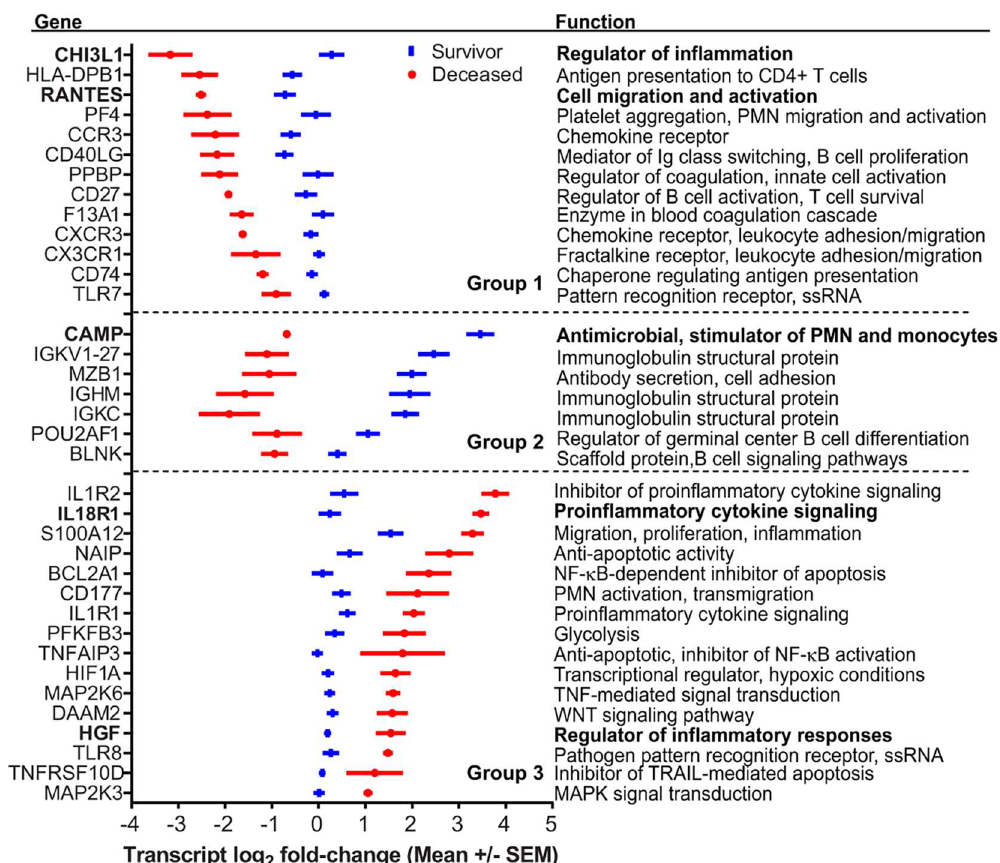
Fig 2. Specific transcripts associated with case fatality. Values are the average normalizedlog 2 fold-change of signal intensities ± Standard Error of the Mean for select transcripts in Groups 1–3 describedin Fig 1. The gene names are shown on the left and the functionalannotationis shown on the right. Genes were selected based on their fold-change in Deceasedvs Survivor (DvS) comparisons and had significant q